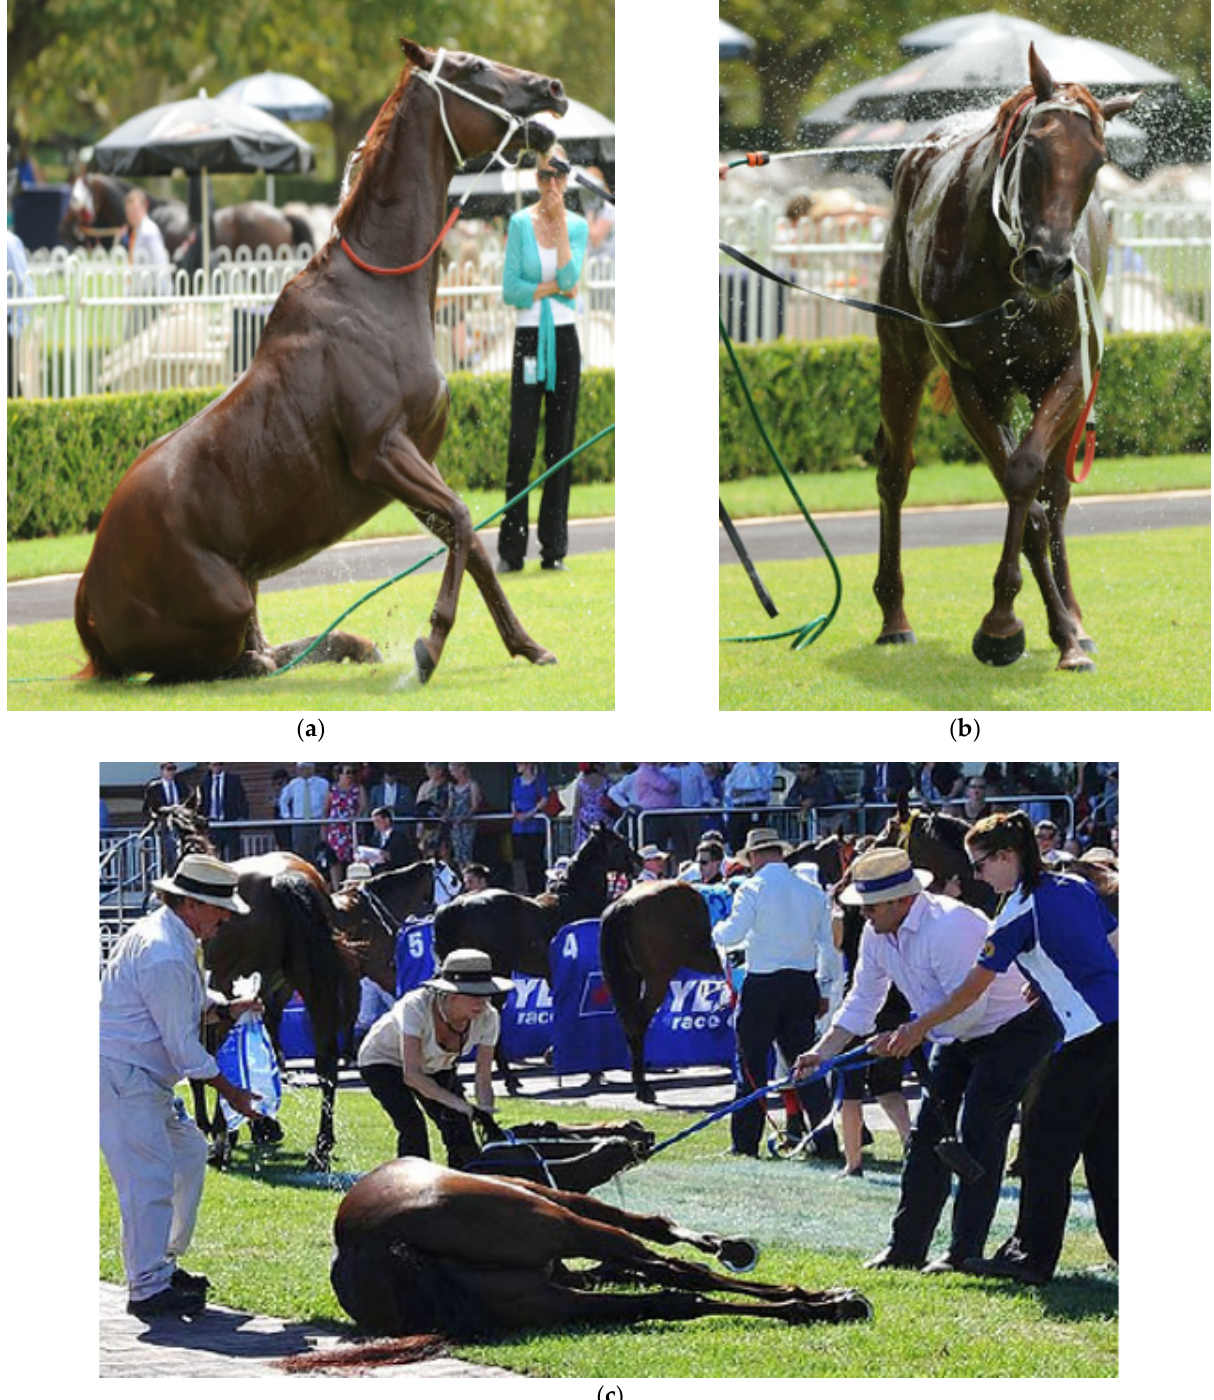
Figure 12. ( a , b ) show a horse that has just returned to the enclosure after racing. It has immediately displayed significant levels of ataxia and has altered mentation. The horse pictured in 12 ( c ) has returned to the enclosure and collapsed. In hot/humid weather EHI is an important provisional diagnosis and horses need to be cooled in the first instance before EHI can be discounted. Figure 12: ( a , b ) source—J Equine Vet Ed, 2021.